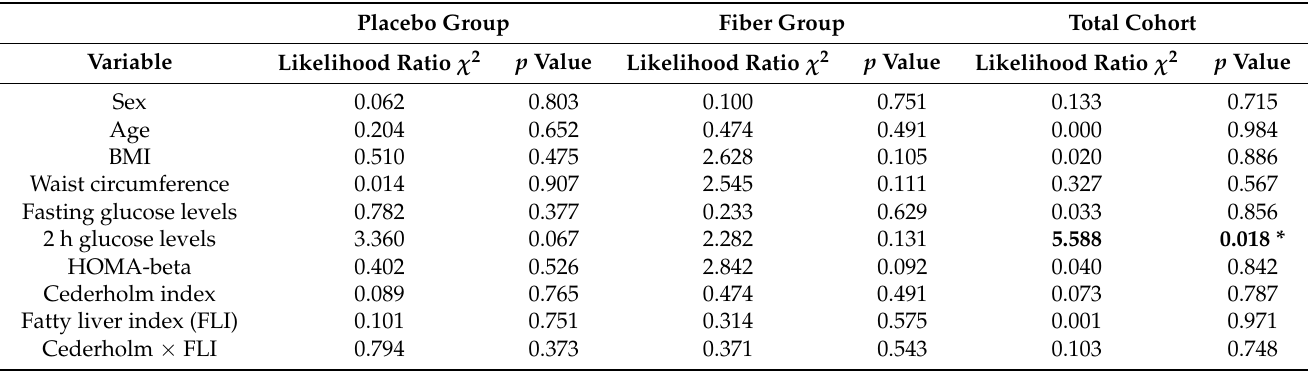
Table 4. Likelihood ratios for multivariate nominal logistic regression model for prediction of conversion to normal glucose regulation. Sex and Cederholm x FLI were analyzed as categorical variables. Significant results are printed in bold; *: p <